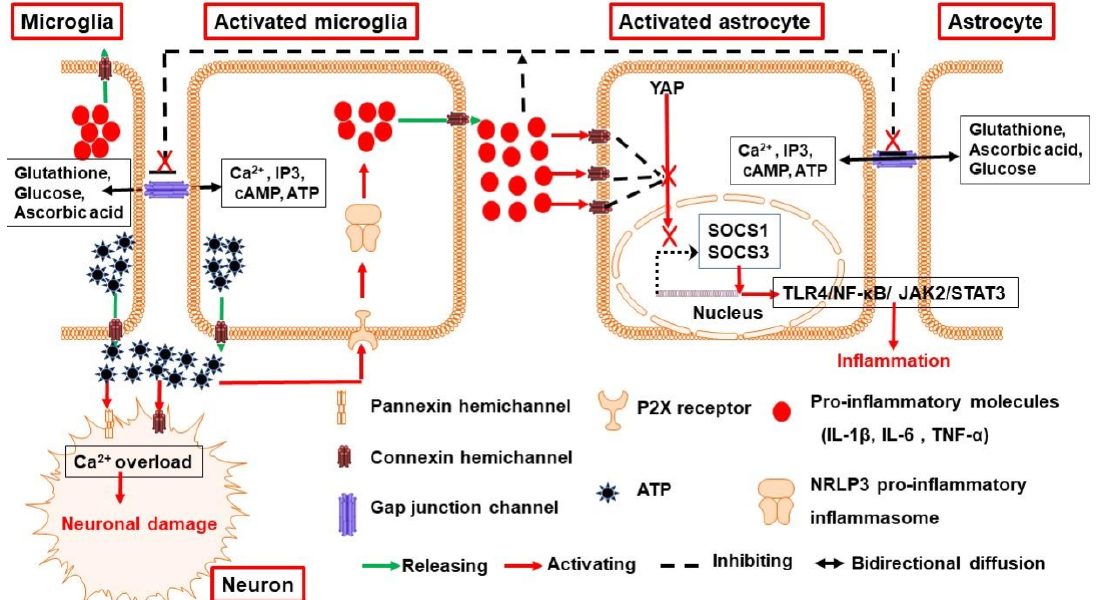
Figure 1. Possible mechanisms by which connexins and pannexins mediates inflammatory responses following ICH. Microglia activated by hematoma degradation products release pro-inflammatory molecules, including IL − 1 β , IL − 6, TNF- α and ATP. These molecules may auto-activate P2X receptors on the membrane of microglia, leading to the activation of NRLP3 pro-inflammatory inflammasome to exacerbate the release of pro-inflammatory molecules. Conversely, they also activate Cx43 hemichan- nels in astrocytes to aggravate the inflammatory responses by inactivating pro-inflammatory YAP- SOCS1-SOCS3-TLR4-NF κ B and JAK2-STAT3 axis pathways. Furthermore, ATP released from Cx43 hemichannels results in the opening of Cx36 hemichannel and Panx1 channels in neurons, eventually causing neuronal damage. ICH, intracerebral hemorrhage; Cx, connexins; Panx, pannexins; P2X, purinergic P2X receptors; NRLP3, nucleotide-binding oligomerization domain-like receptor family, pyrin domain-containing − 3; HCs, hemichannels; GJIC, gap junctional intercellular